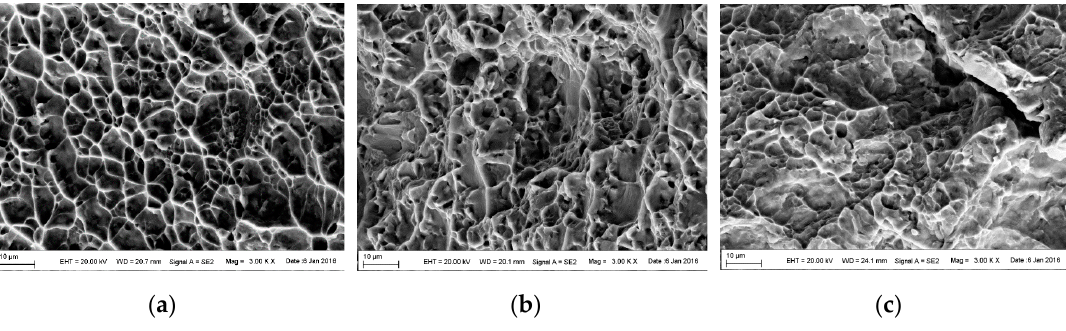
Figure 7. ( a ) Fracture morphology in the ductile extension region of the smooth tensile specimen; ( b ) fracture morphology in the ductile extension region of the specimen with the 1.5 mm notch; and ( c ) fracture morphology of smooth tensile specimen under 2000 s − 1 . Table 2. Revised JC failure parameters of the 2618 aluminum alloy and the Ti-6Al-4V titanium alloy. Parameters